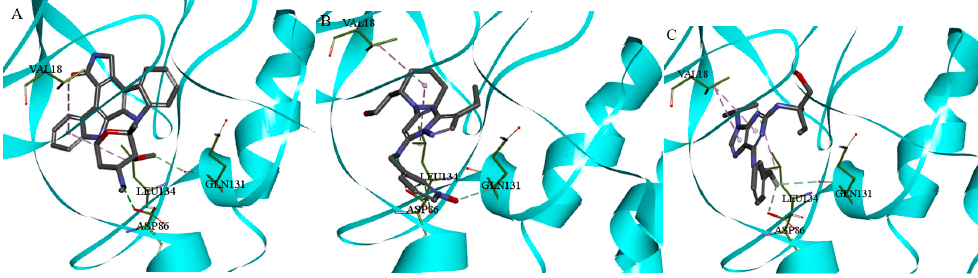
Figure 4. Docking results between Staurosporine ( A ); Dinaciclib ( B ); and Roscovitine ( C ) and CDK2 ATP binding site.